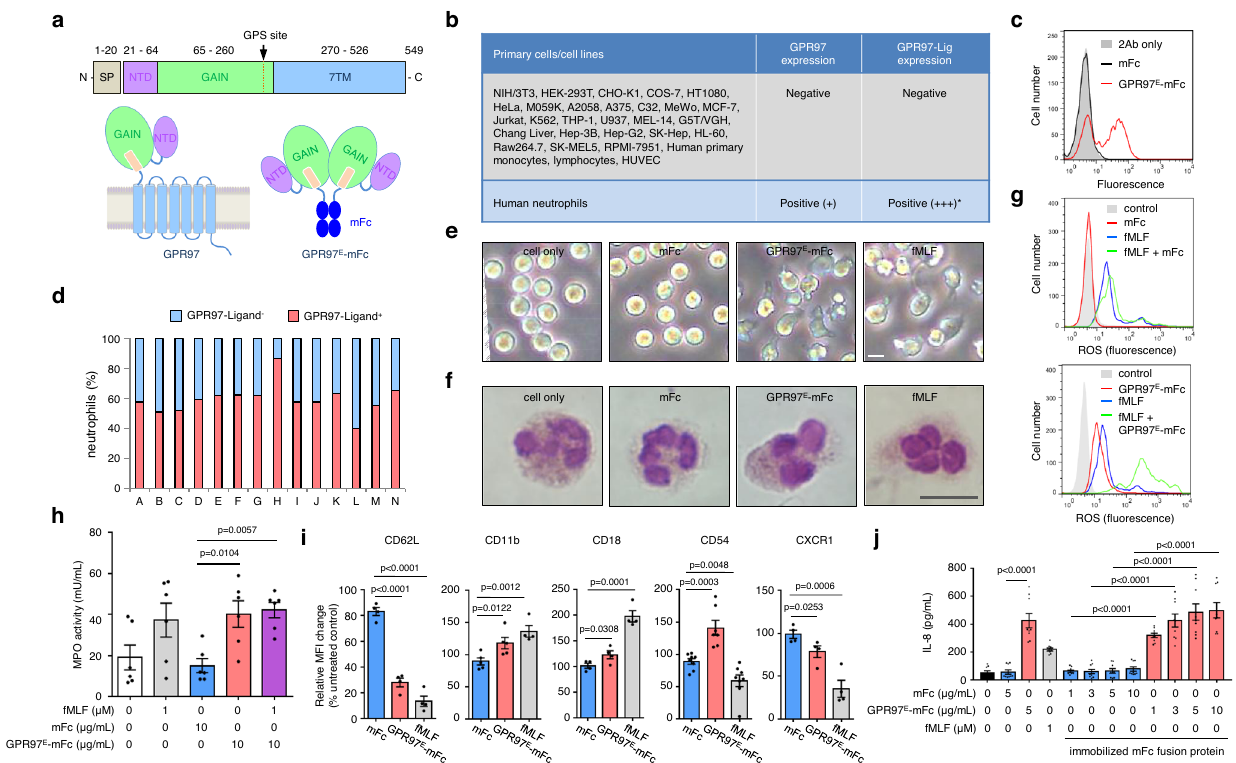
Fig.2|Identi fi cationofaputativeGPR97-ligandinadistincthumanneutrophil subpopulation that is activated upon interaction with GPR97 E -mFc. a Schematics of GPR97 receptor and GPR97 E -mFc probe. b List of cell samples screened for the expression of GPR97 and the putative GPR97-ligand. * indicates a subpopulation of primary human neutrophils. c A representative bimodal surface expression pro fi le of the GPR97-ligand in human neutrophils detected by the (pink) neutrophil subsets in bloods of different donors (samples A to N). e , f Morphological changes of neutrophils induced by GPR97 E -mFc as observed by